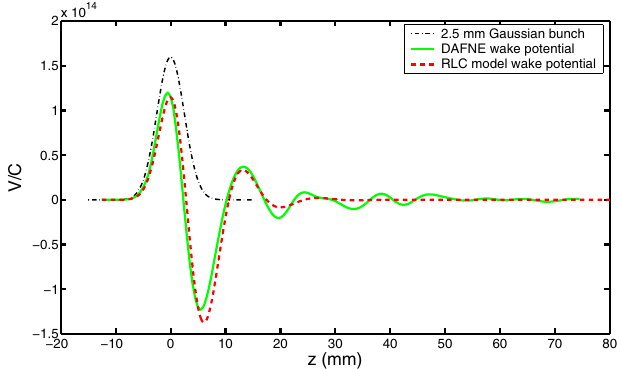
FIG. 6. (Color) Comparison between the DA (cid:1) NE wake poten- tial for the 2.5 mm bunch and the wake potential obtained by a RLC model.